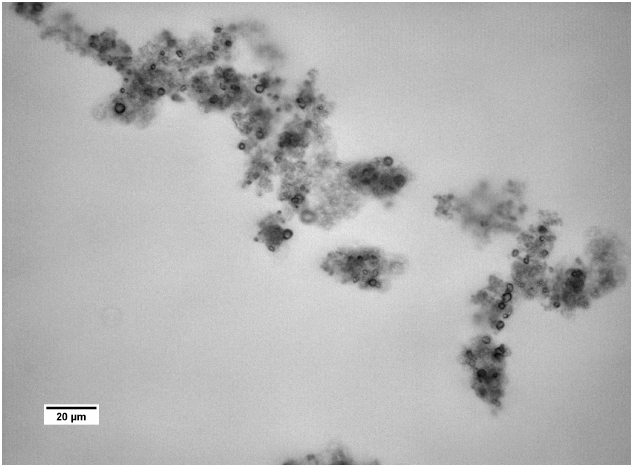
Figure 3. Micrograph of organic-inorganic agglomerates obtained in the presence of a protein mixture (0.1% of albumin and lysozyme, 24 h).